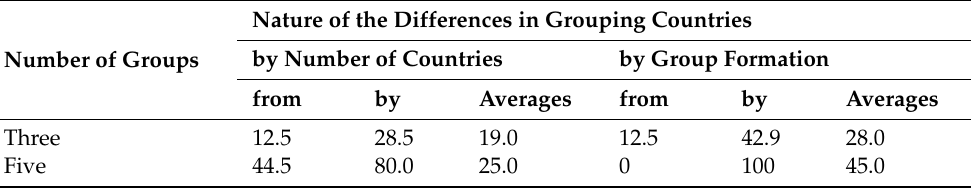
Table 5. Differences between countries in linear and non-linear grouping as a percentage. Nature of the Differences in Grouping Countries by Number of Countries by Group Formation Number of Groups from by Averages from by